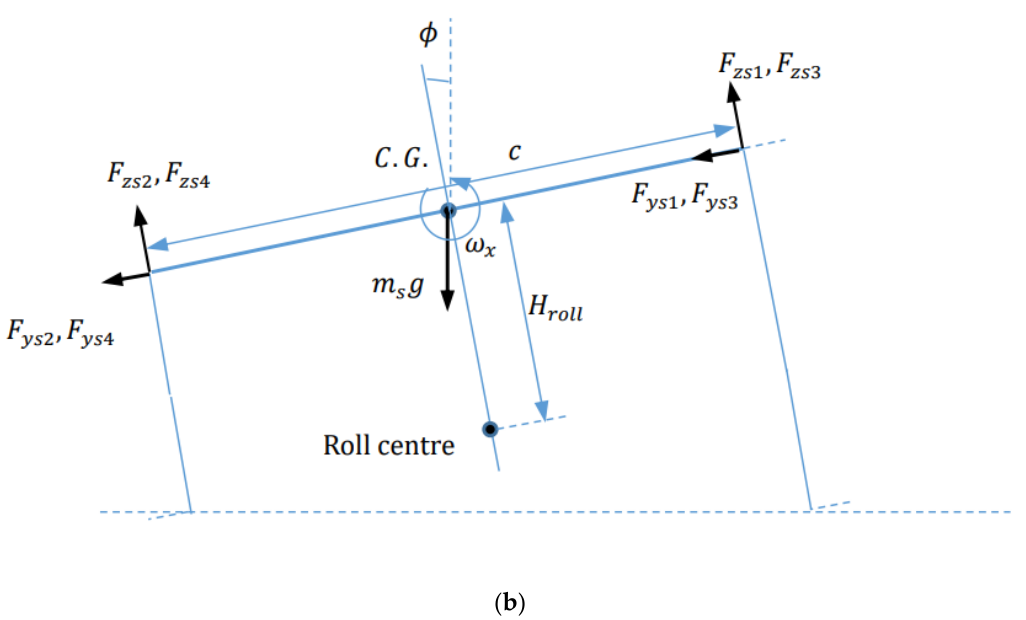
Figure 1. Schematic of 14 DOF vehicle dynamics model ( a ) yaw plane ( b ) roll plane.